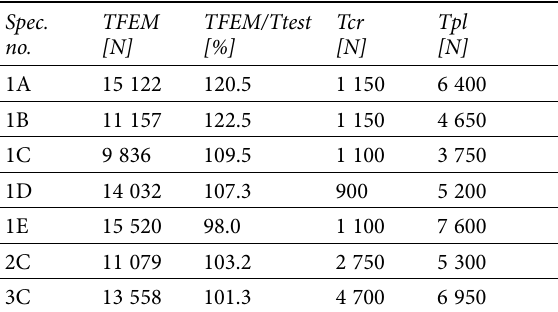
from FEA. Table 3. Results of finite element analysis Spec. no.